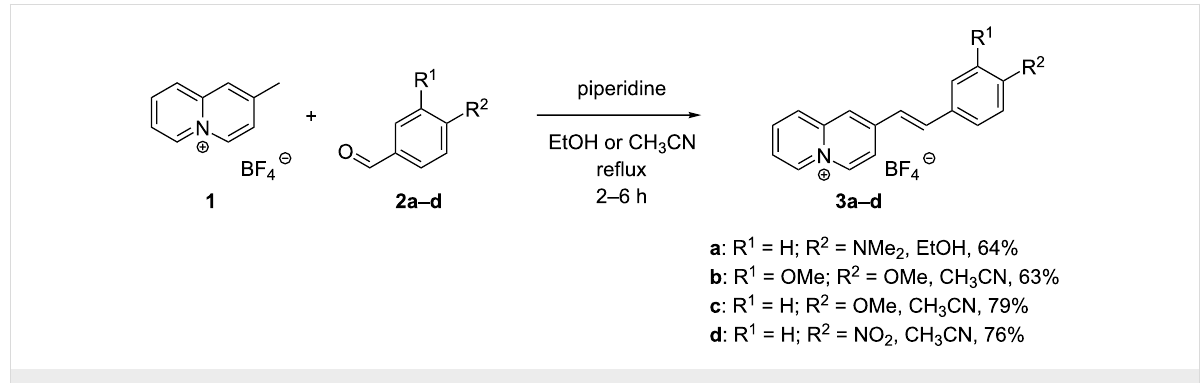
Scheme 1: Synthesis of styrylquinolizinium derivatives 3a – d